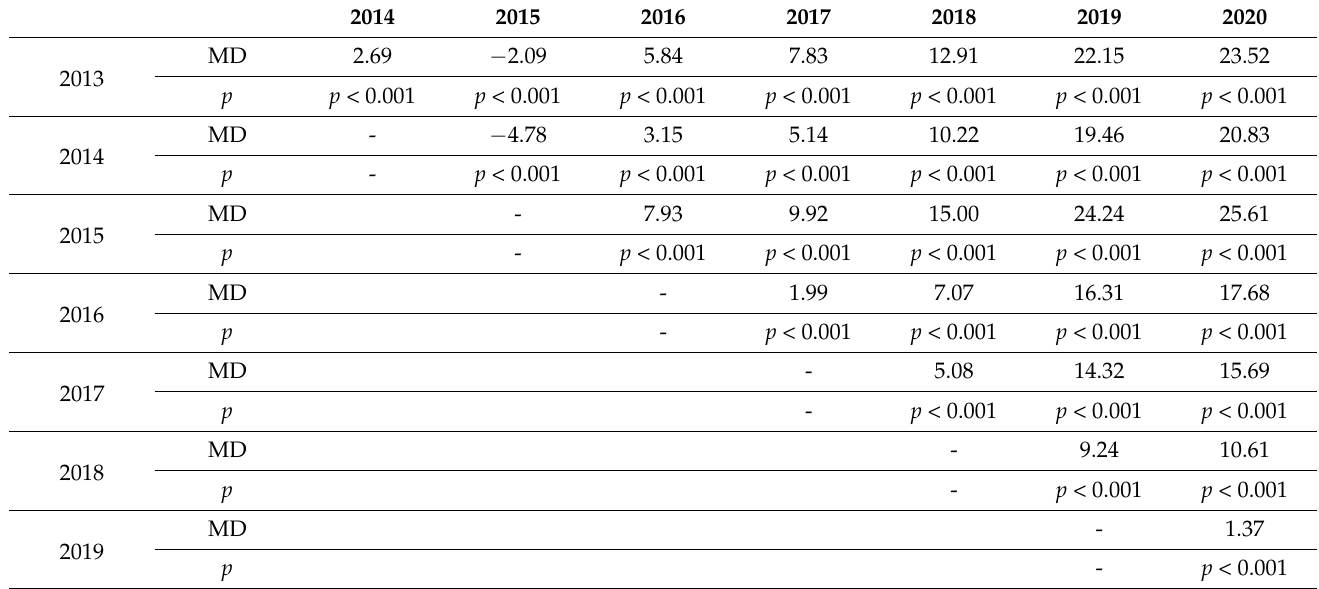
Table 14. Comparison of the use of tracheal intubation between individual editions of the Championships.